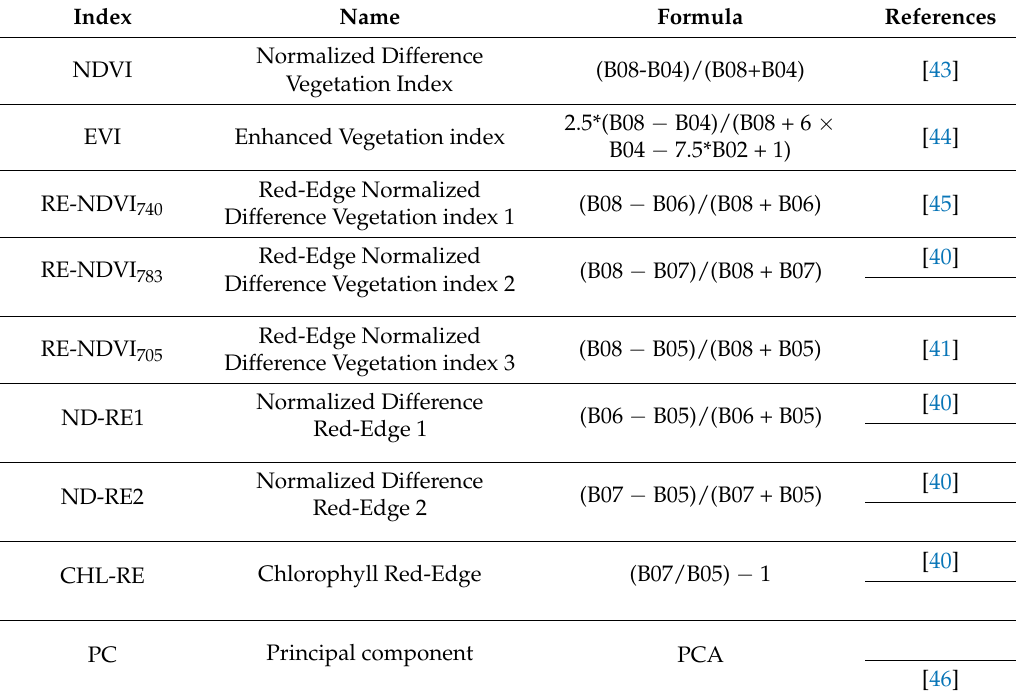
Table 3. Vegetation indices calculated from the Sentinel-2